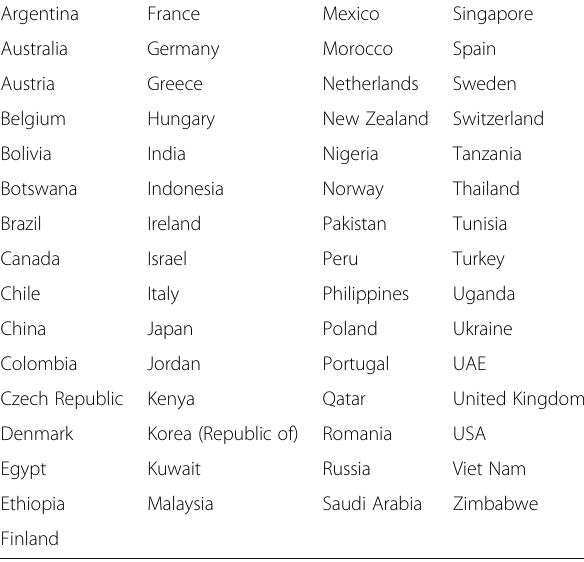
Table 3 Countries used for quantitative analyses between The Culture Map & Global Innovation Index